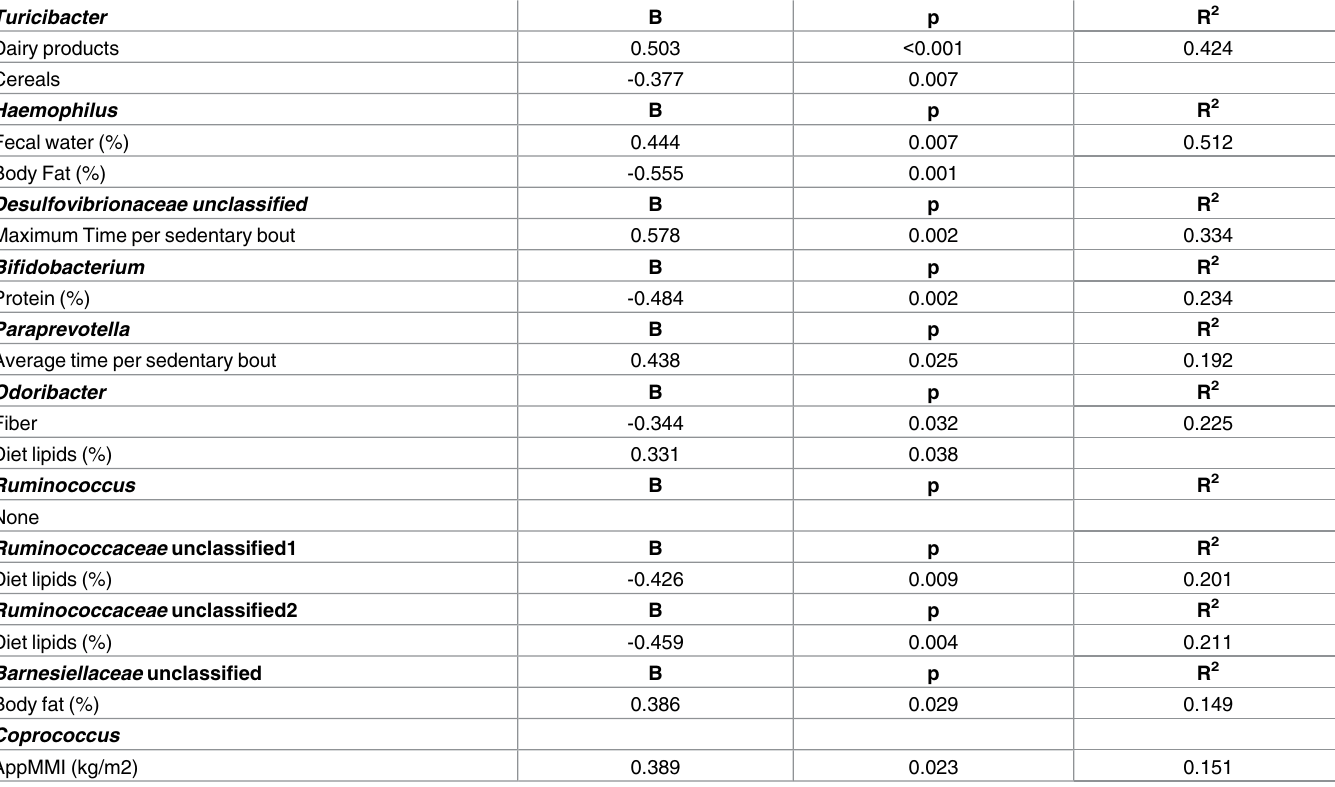
Table 4. Multivariate linear regression analysis of the bacterial groups significantly different between active and sedentary women as dependent variants, and diet composition, fecal water, body composition parameters and physical activity parameters as independent variables.